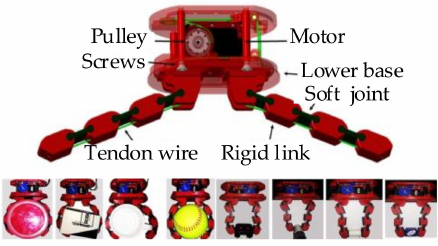
Figure 7. Object grasping with a soft grasper